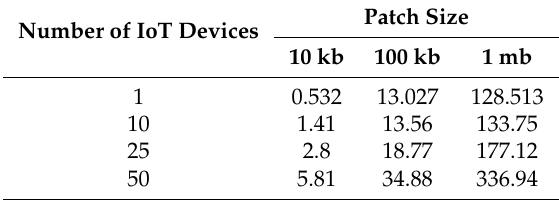
Table 3. Performance measure of distribution latency (sec).